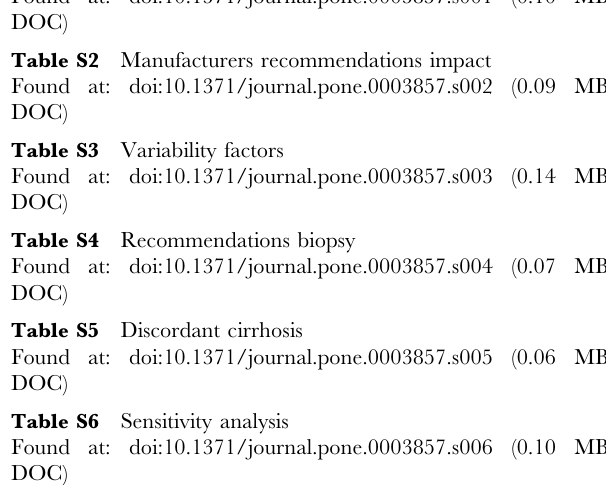
Table S1 Characteristics